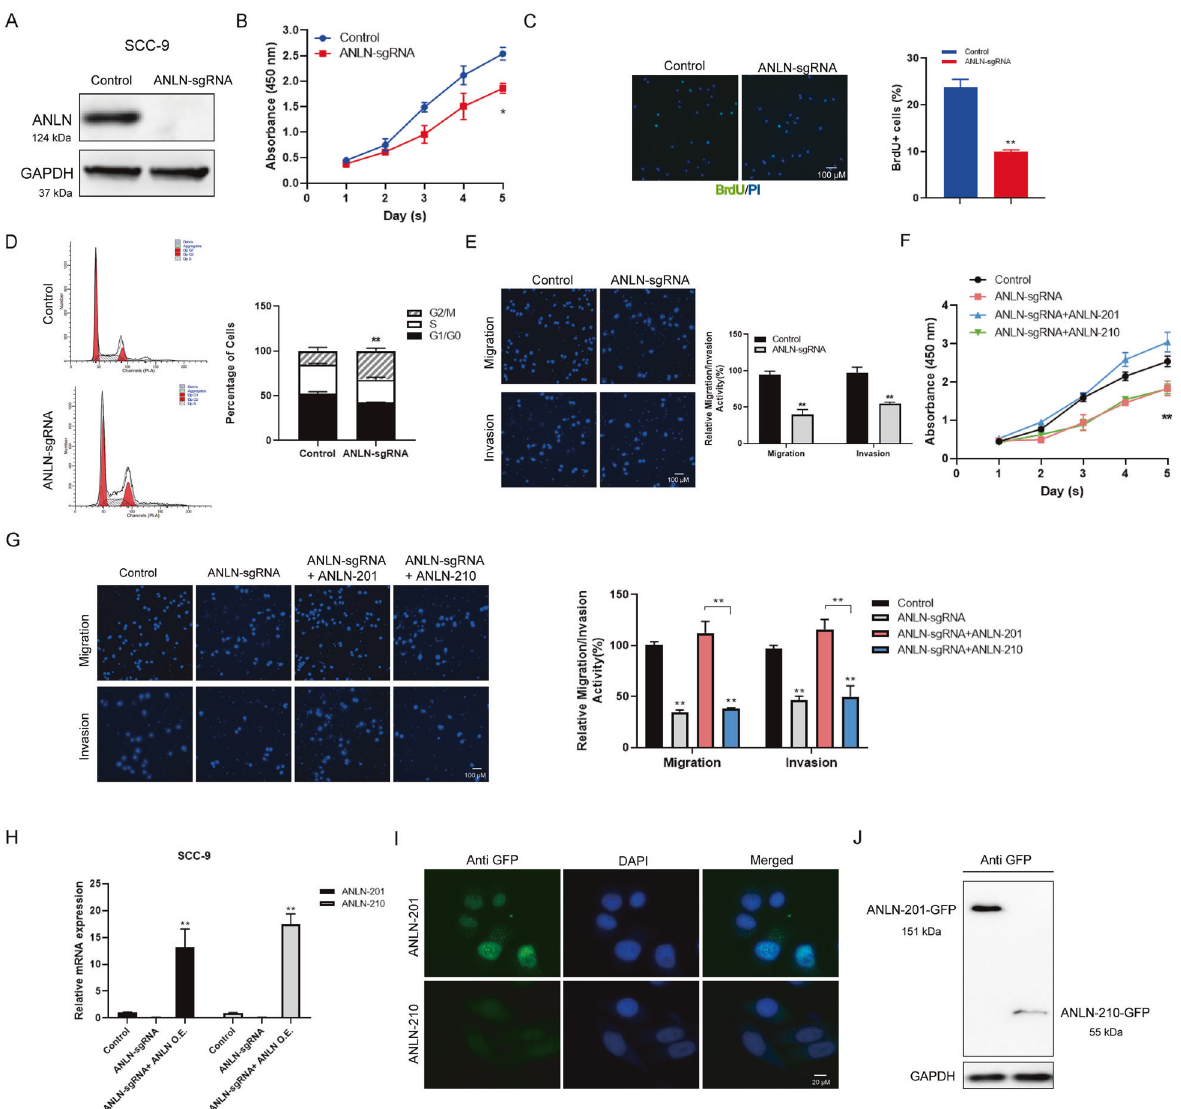
performed to measure cell proliferation in ANLN-sgRNA SCC-9 cells. * P < 0.05, ** P < 0.01. D Cell cycle analysis was used to analyze the change of cell cycles induced by ANLN knockout. * P <0.05, ** P < 0.01. E Transwell and transwell-matrigel assays were performed to measure cell migration and cell invasion caused by ANLN knockout. * P < 0.05, ** P <0.01. F Cell proliferation was assessed in ANLN-sgRNA SCC-9 cells transfected with GFP-ANLN- 201 or GFP-ANLN-210. * P < 0.05, ** P <0.01. G Cell migration and cell invasion were analyzed in ANLN-sgRNA SCC-9 cells transfected with